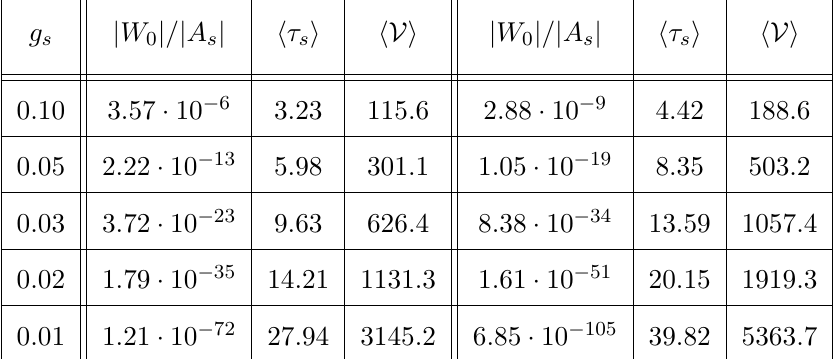
Table 4 . Numerical analysis for SO(8) -configuration. Left : Minkowski minima for the effective χ eff . Right : Minkowski minima for the full χ .